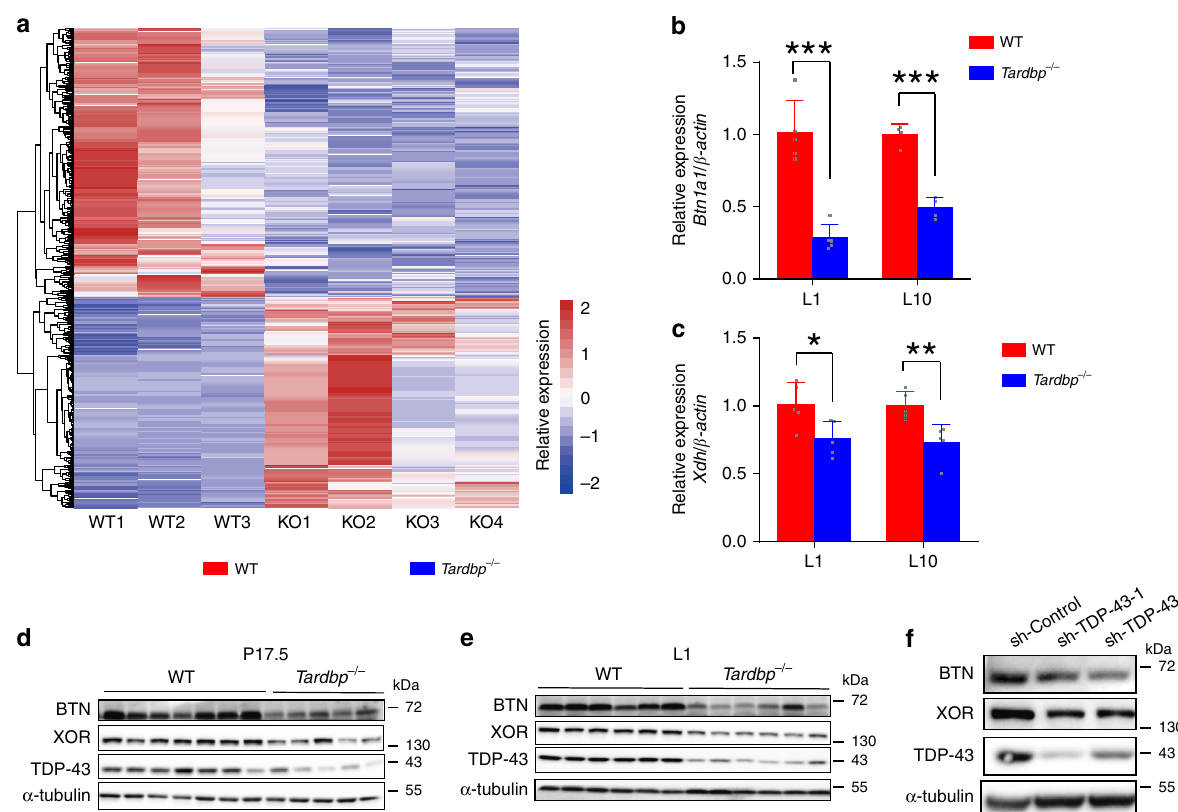
Fig. 4 TDP-43 regulates expression of BTN and XOR. a Heatmap of differentially expressed genes from mammary glands between wild-type (WT, n = 3) and Tardbp − / − (KO, n = 4) mice at lactation day 1 (L1). Colors of bars represent normalized and scaled expression levels (red, white, and blue correspond to highest, middle, and lowest values, respectively). b Quantitative real-time PCR (qRT-PCR) analysis of Btn1a1 expression in WT and Tardbp − / − mice at L1 ( n = 5 mice) and L10 ( n = 4 mice). c Quantitative real-time PCR analysis of Xdh expression in WT and Tardbp − / − mice at L1 ( n = 5 mice) and L10 ( n = 5 mice). d , e Western blot showing expression of BTN and XOR in MECs isolated at pregnancy day 17.5 ( d ) and L1 ( e ) from WT and Tardbp − / − mice. f Protein levels of BTN and XOR in differentiated HC11 cell line upon Tardbp knockdown. Data are means ± SD. Unpaired t test was used to evaluate statistical signi fi cance. * P < 0.05; ** P < 0.01. Source data are provided as a Source Data fi